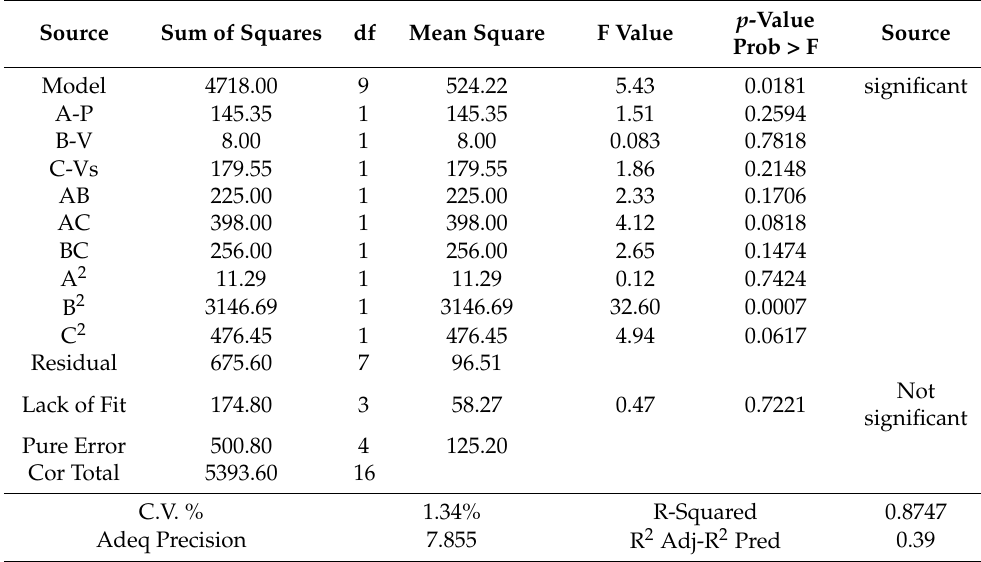
Table 7. Variance analysis of tensile strength fitting model.